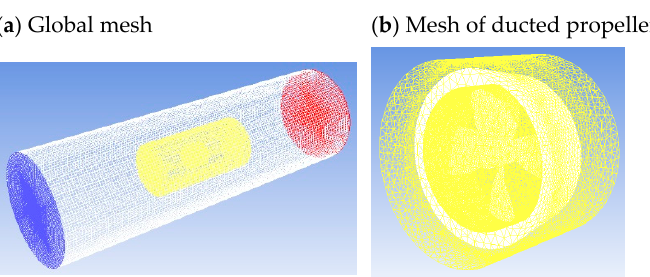
Figure 1. Calculation domain grids of the test ducted propeller. ( a ) Global mesh; ( b ) Mesh of ducted propeller.